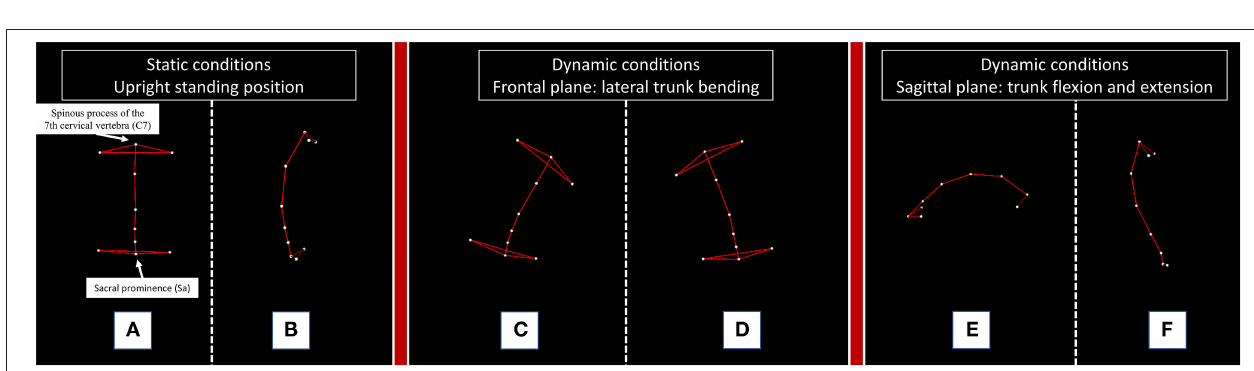
FIGURE 2 | Kinematic analysis of trunk movement in static and dynamic conditions performed by a representative subject. The figure illustrates the static and dynamic tasks performed by a representative healthy subject. C7: the spinous process of the 7th cervical vertebra; Sa: sacral prominence. For the measurement of lateral (A) and anterior (B) trunk deviation, we considered the absolute deviation of the “C7-Sa” segment from the vector perpendicular to the floor of our movement analysis laboratory during the static upright standing position. For the dynamic tasks, we calculated the range of motion (ROM) of the trunk, defined as the maximum angle described by the C7-Sa segment starting from the upright standing position to the end of a right (C) or left (D) trunk bending, a forward trunk flexion (E) and a posterior trunk extension (F)